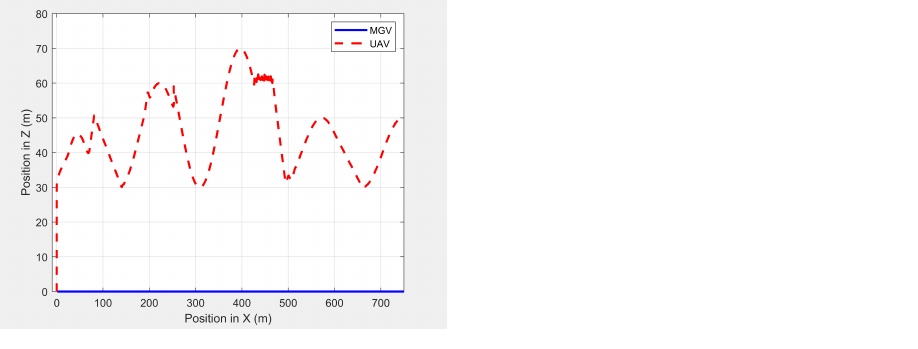
Figure 20. Variation in the altitude of the UAV’s planned path with the horizontal position when following the MGV in the presence of static obstacles.